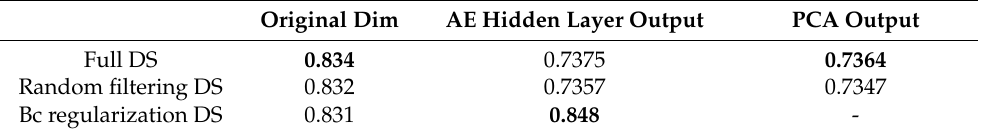
Table 3. Results of GB-based classification of the datasets with different filtering methods and different feature sets. The barycenter-based minimization (Bc) without a stabilizer method limits the cluster size to be in range 50–89%. The ID s obtained cluster size is 1709 with 831 of outliers ( UD